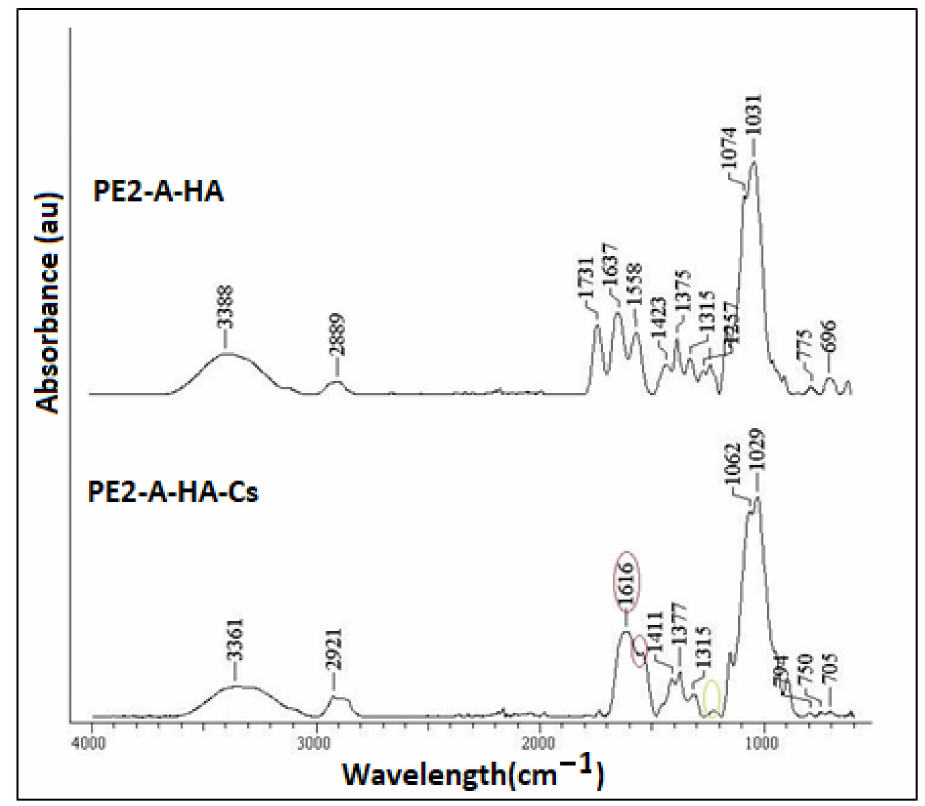
Figure 5. FTIR data for PE2-A-HA and PE2-E-HA-Cs